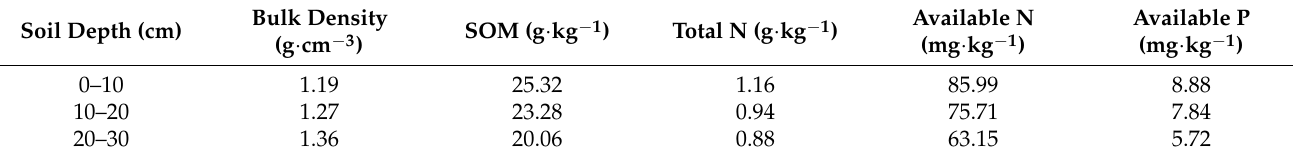
Table 1. Basic physical and chemical properties of the soil in November